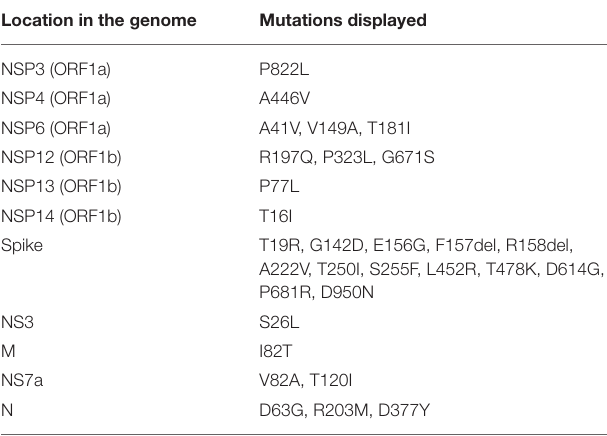
TABLE 2 | List of mutations displayed in the different regions of the genome of SARS-CoV-2 in the sequence obtained in this study. Location in the genome Mutations